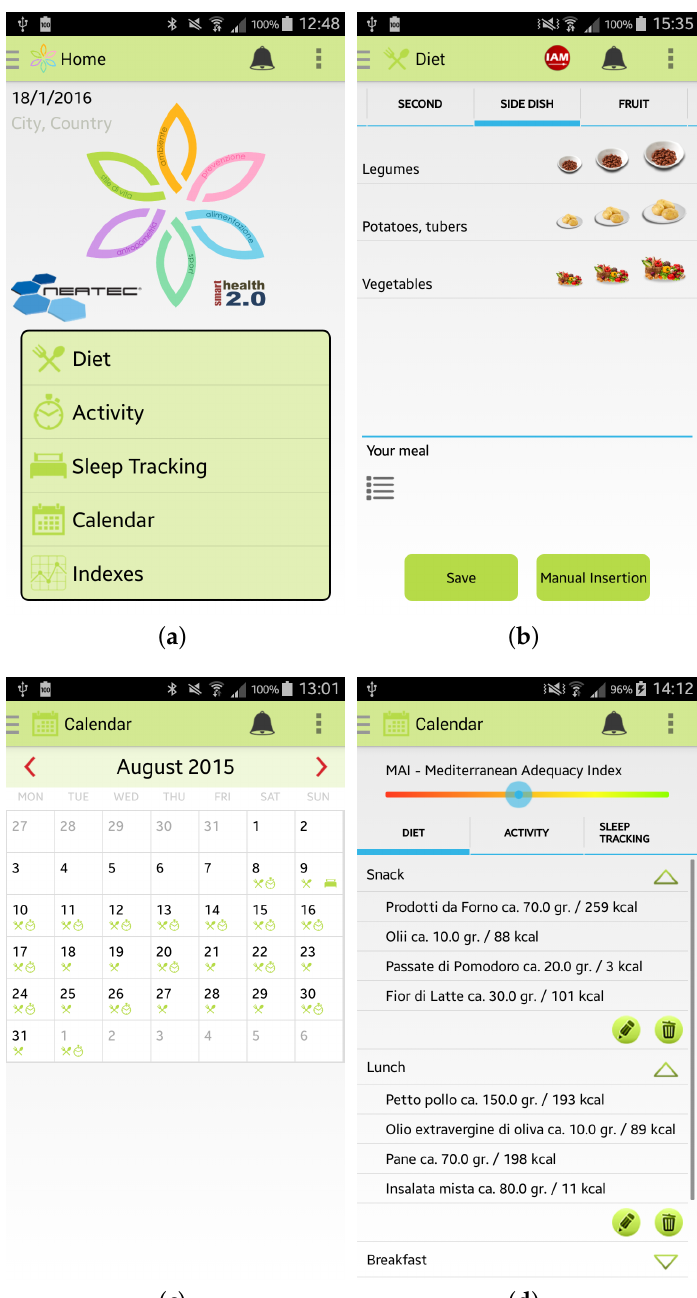
Figure 3. Screenshots of the Wellness App: ( a ) Main Menu; ( b ) Insertion of a new meal; ( c ) Calendar; and ( d )